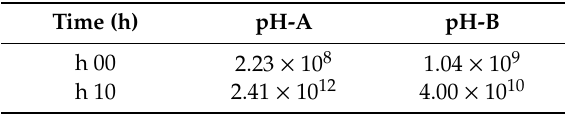
Table 4. Average colony forming unit (CFU) counts for zero and final-hour fermentation samples from pH-A and